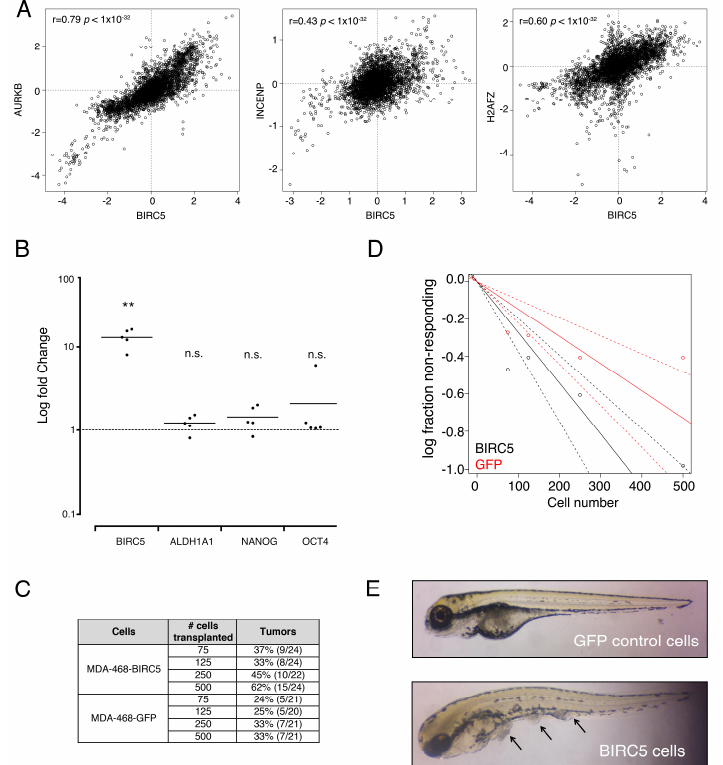
Figure 3. Participation of the Chromosomal Passenger Proteins Module (CPPM) in the stem cell phenotype of MDA-MB-468 cells. ( A ) Gene co-expression. Dot plots show the correlation between the expression of BIRC5 and AURKB (left panel), INCENP (middle panel) and H2AFZ (right panel). ( B ) MDA-MB-468 cells were transiently transfected with a vector containing a BIRC5 open reading frame and subjected to qRT-PCR for the genes shown. Log fold change refers to the logarithmic ratio between BIRC5-overexpressing cells versus empty vector-expressing cells [27], using the ∆∆ Ct method, with SDHA as a housekeeping gene. Each dot represents an independent transfection. BIRC5 p = 0.0012, ALDH1A1 p = 0.1547, Nanog p = 0.1137 and Oct4 p = 0.3128 (** p < 0.01, n.s. = non-significant). ( C ) Xenotransplant dilution assays using a zebrafish model. Table showing tumor frequencies 4 DPI. # cells: number of cells injected. For each experiment, 30 embryos were used and only informative (e.g., surviving) embryos were assessed. Percentages and number of fishes with or without tumors are shown. MDA-468-BIRC5 cells overexpress BIRC5 and MDA-468-GFP overexpress a GFP transgene (control cells). ( D ) Limiting dilution analysis obtained with the Extreme Limiting Dilution Assays (ELDA) software. The plot shows the percentage of the embryos with abdominal tumors injected with MDA-MB-468 cells overexpressing BIRC5 or GFP-expressing (control) cells at 4 DPI. The di ff erence between the analyzed groups was significant (** p = 0.015; estimated stem cell frequency 1 / 369 vs. 1 / 685 in BIRC5- and GFP-expressing cells, respectively; n.s. non-significant). ( E ) Examples of tumors formed in these assays